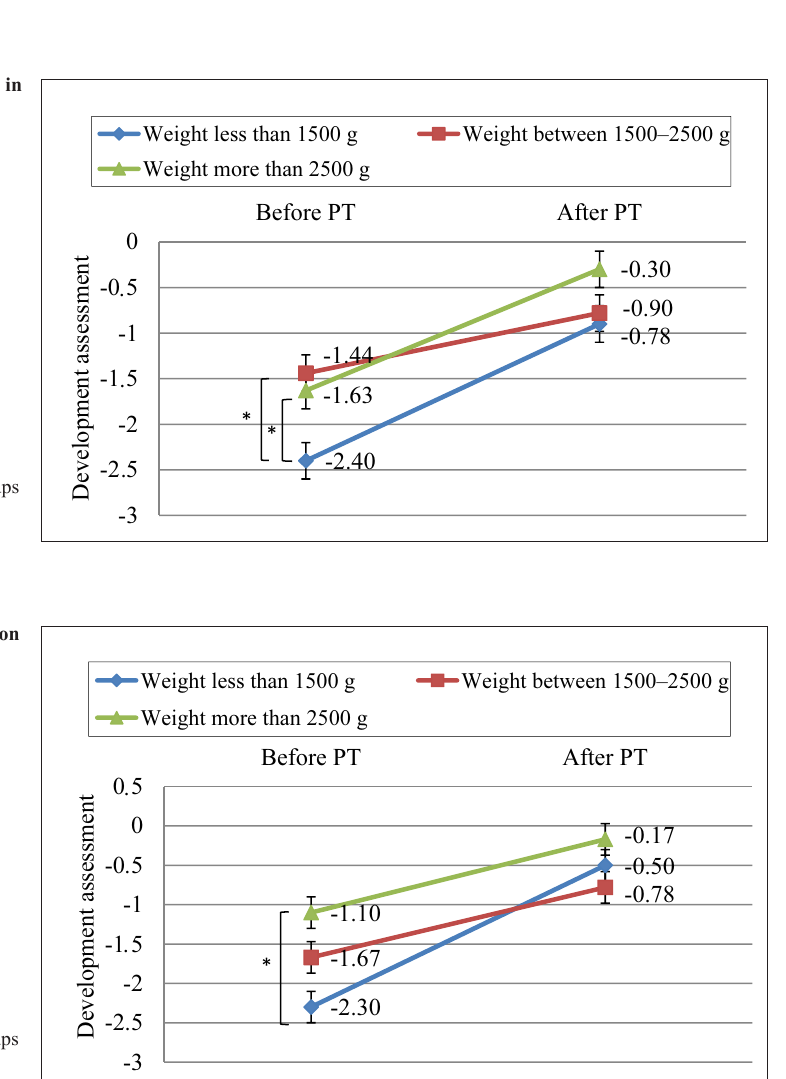
Figure 4. Grasping up development evaluation in different birth weight infant groups